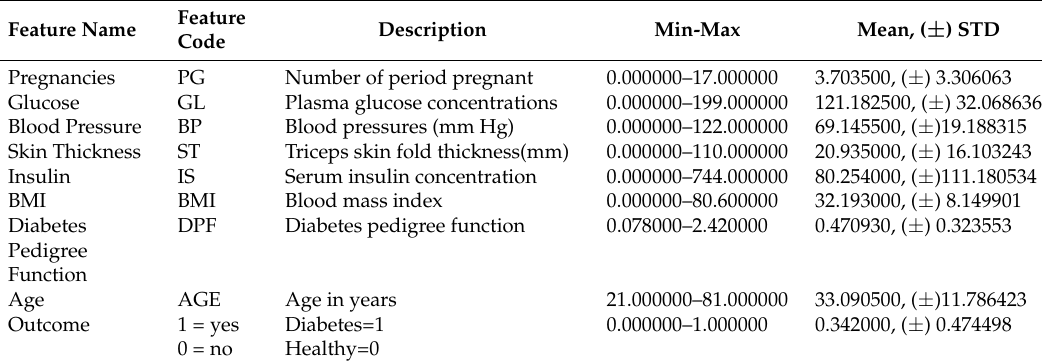
Table 2. The Diabetes dataset description along with some statistical operations.